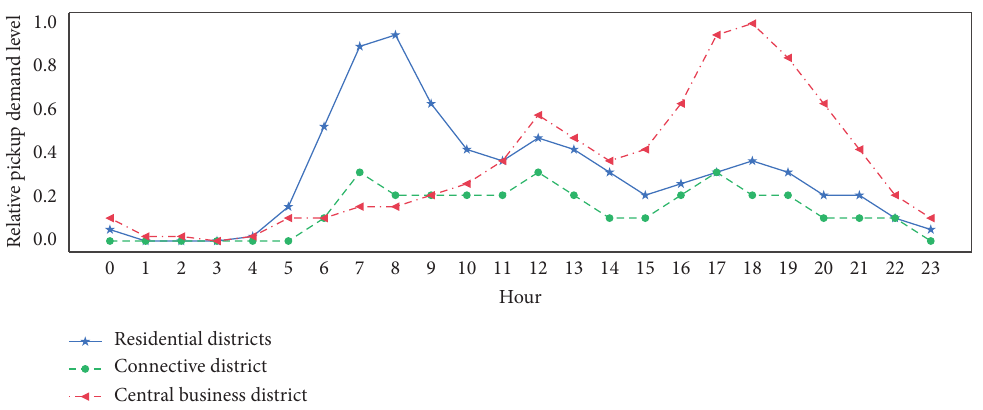
Figure 10: Relative pickup demand level for virtual parking spots in each district.